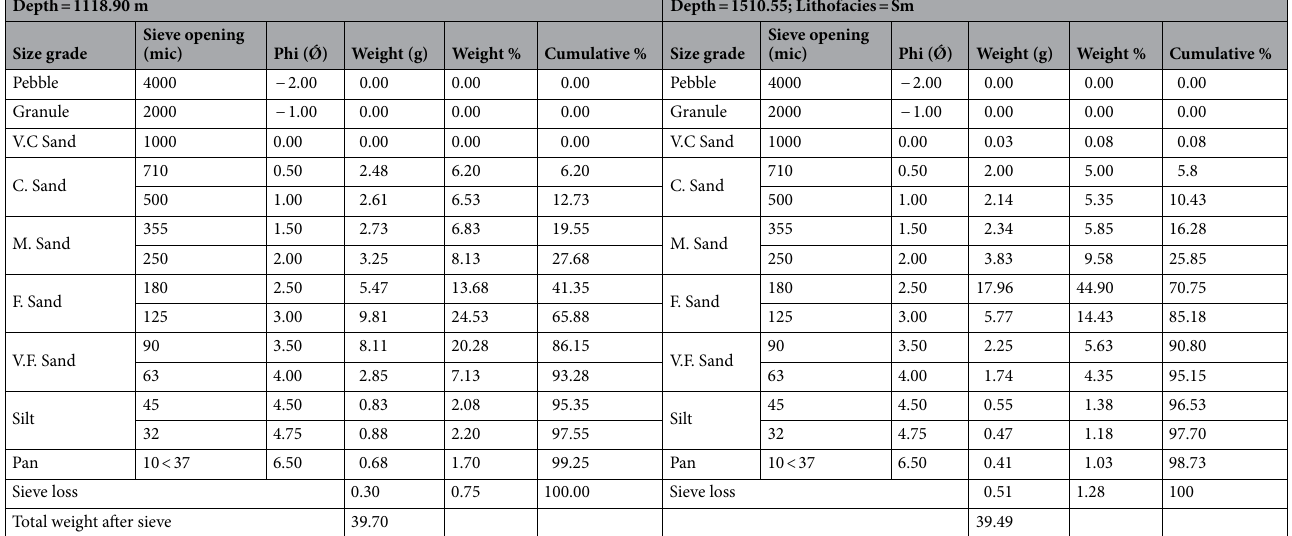
Table 4. Summary of grain size analysis.